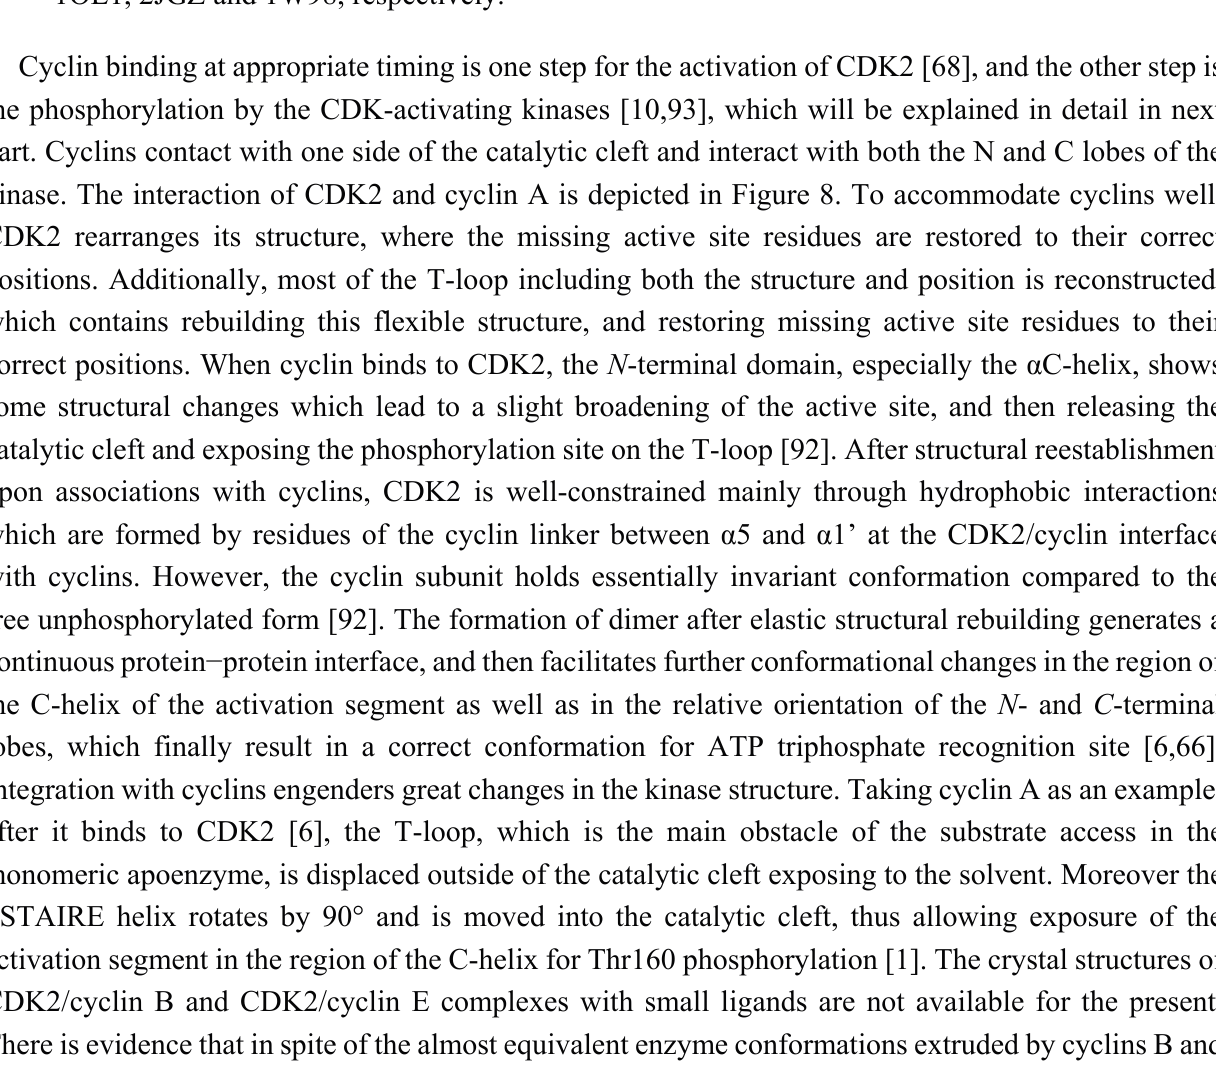
Figure 7. Schematic diagrams showing the structures of cyclins A, B and E, as well as their corresponding secondary structural elements. Coordinates used for cyclins A, B and E are 1OL1, 2JGZ and 1W98,